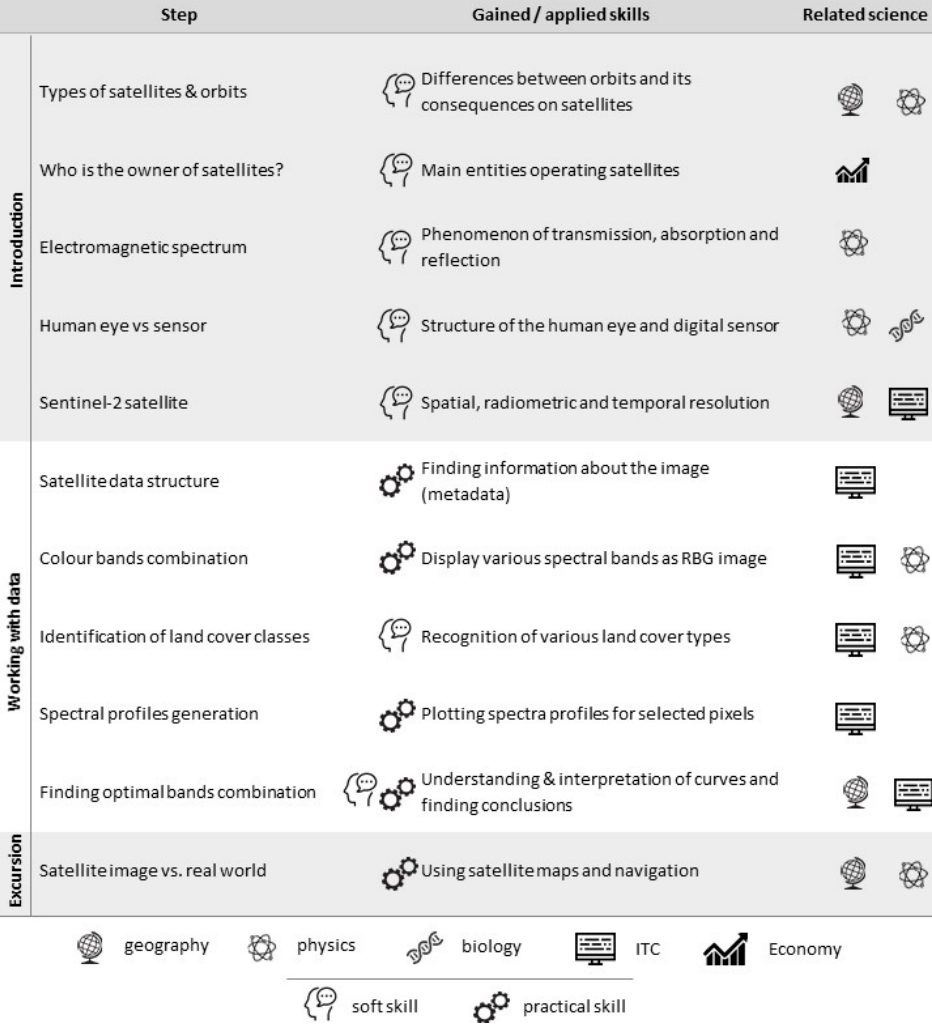
Figure 1 . Workflow of the project with main steps, associated skills, and branches of science. Figure 1. Workflow of the project with main steps, associated skills, and branches of